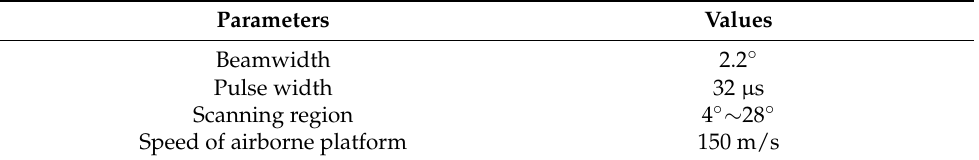
Table 3. System parameters of the real